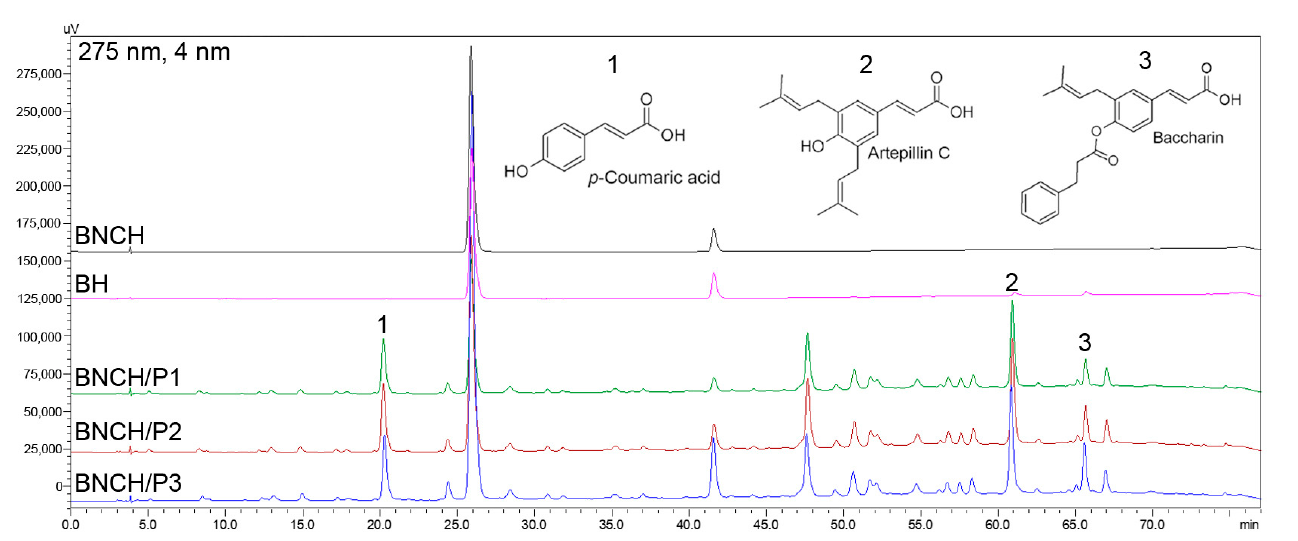
Figure 2. Viscosity of all BC-based hydrogel formulations. The viscosity is dependent on propolis content.